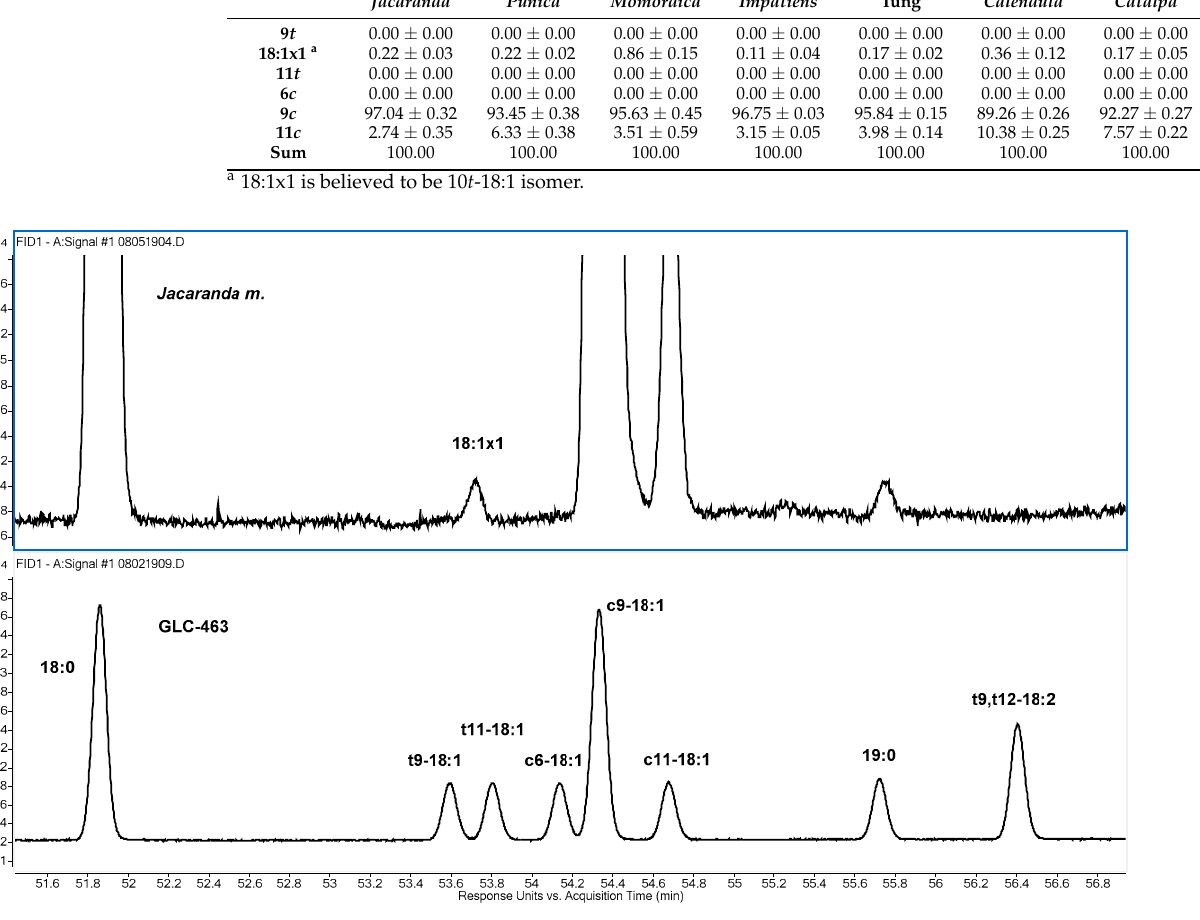
Figure 2. FID chromatograms of Jacaranda m. and GLC 463 FAME standard on SP-2560 column showing positions of 18:1 isomers.